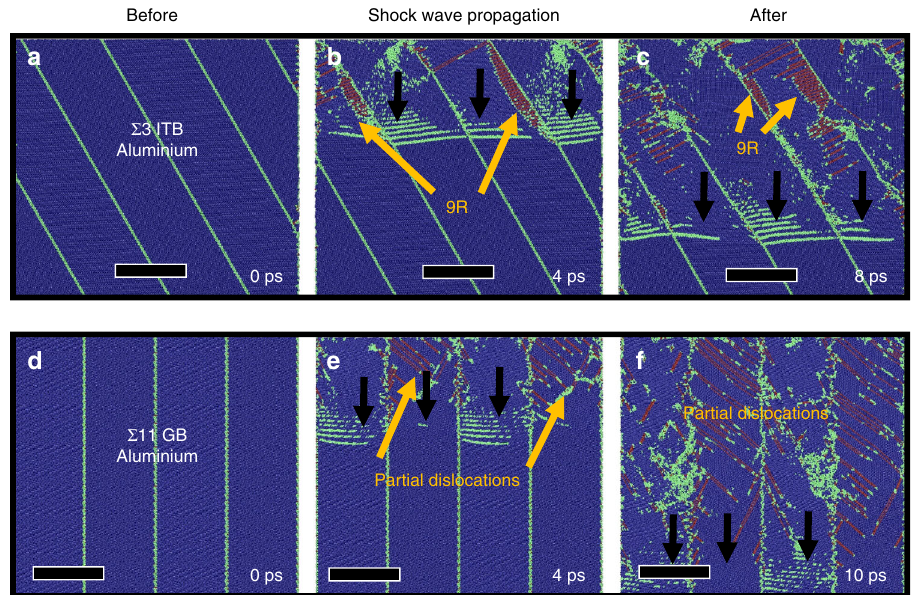
Fig. 6 Molecular dynamics simulation of the shock-induced activity of partials in ∑ 11 GB and ∑ 3 ITB. a – c Snapshots of shock-induced dissociation of partial dislocations from compacted ∑ 3 {112} ITB in Al. a The ∑ 3 ITB with 15 nm domain size in Al fi lm. Scale bar here and in subsequent panels is 15 nm. b , c When the shock wave passes through the ITBs, the 9R phase forms due to the dissociation of ITBs by the emission of partial dislocations from the ITBs. The red area bounded by the green lines is the 9R phase. d – f The snapshots of shock-induced nanotwin and partials (nucleation and emission of partial dislocations from ∑ 11 GB). d The ∑ 11 GB with 15 nm domain size in Al fi lm. The GB contains Shockley partial dislocations every seven {111} atomic planes. e , f Partial dislocations are emitted from the GBs due to the shock